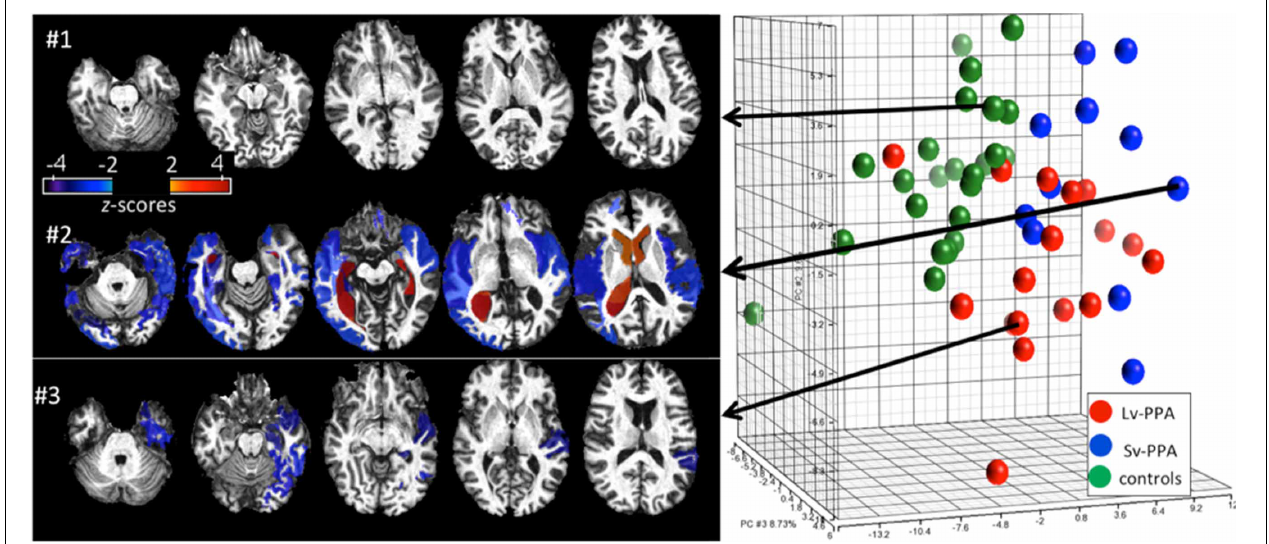
FIGURE 8 | Representation of degrees of regional atrophy as z -scores to support diagnosis (left panel). In cross-sectional studies on patients with similar diagnostic criteria, the patterns of atrophy from populations can be integrated with clinical information providing diagnostic and prognostic